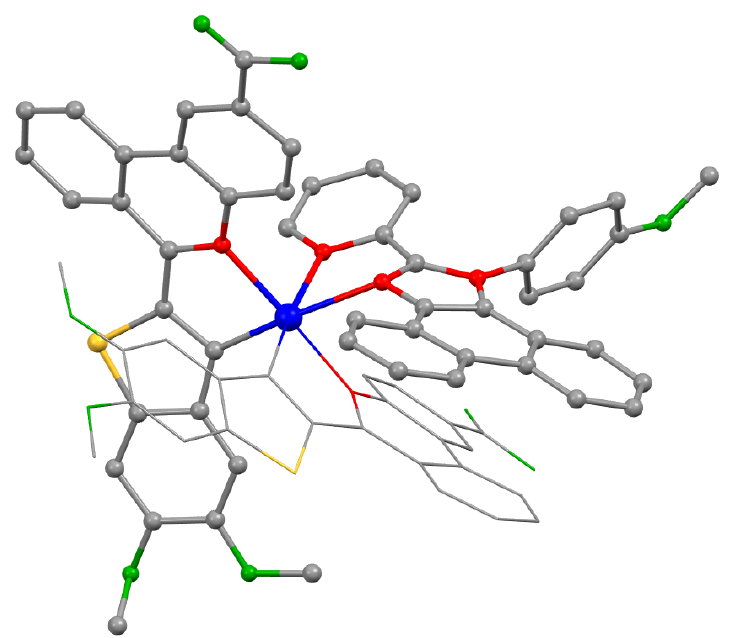
Figure 1. Structure of complex 7 (DFT optimized S 0 state). Colors of atoms: Ir, blue; S, yellow; O, green; N, red; C, grey. Hydrogen atoms are omitted for clarity; one of the N^C ligands is shown in wireframe style to simplify visualization. Table 1. Photophysical data for complexes 1 – 7 in methanol solution, 298